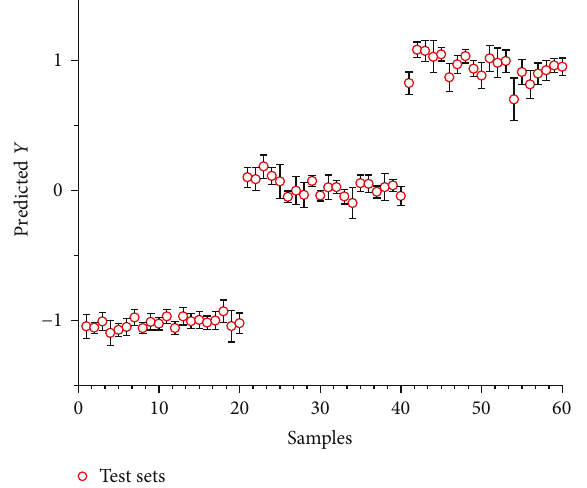
Figure 7: PLS-DA model scores plot of the predicted Y values and values of samples for test sets.